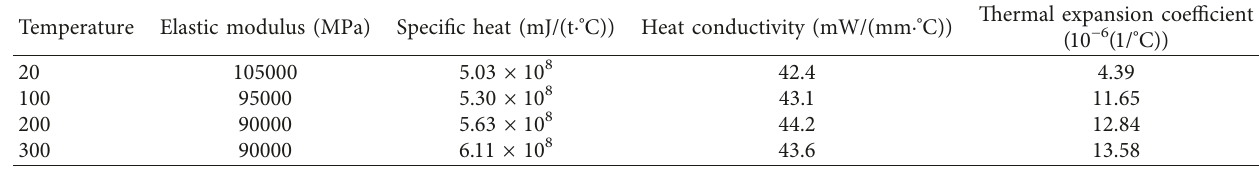
Table 2: Thermophysical properties of the brake disc.